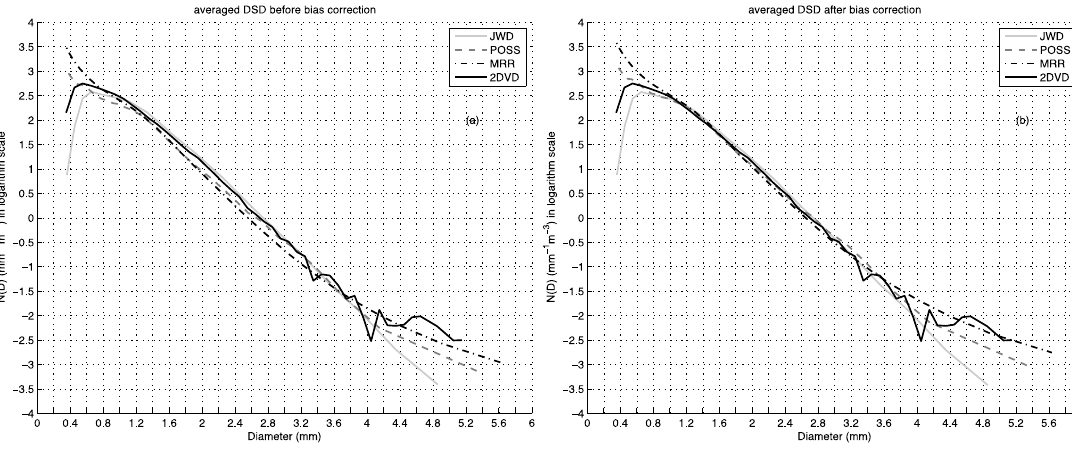
Figure 6. ( a ) Averaged DSD from 2DVD, POSS, MRR and JWD before applying bias correction. ( b ) Same as in ( a ), except after applying bias correction. The average rainfall rate is about 3.7 mm h − 1 from bias corrected DSD from 16 disdrometers.